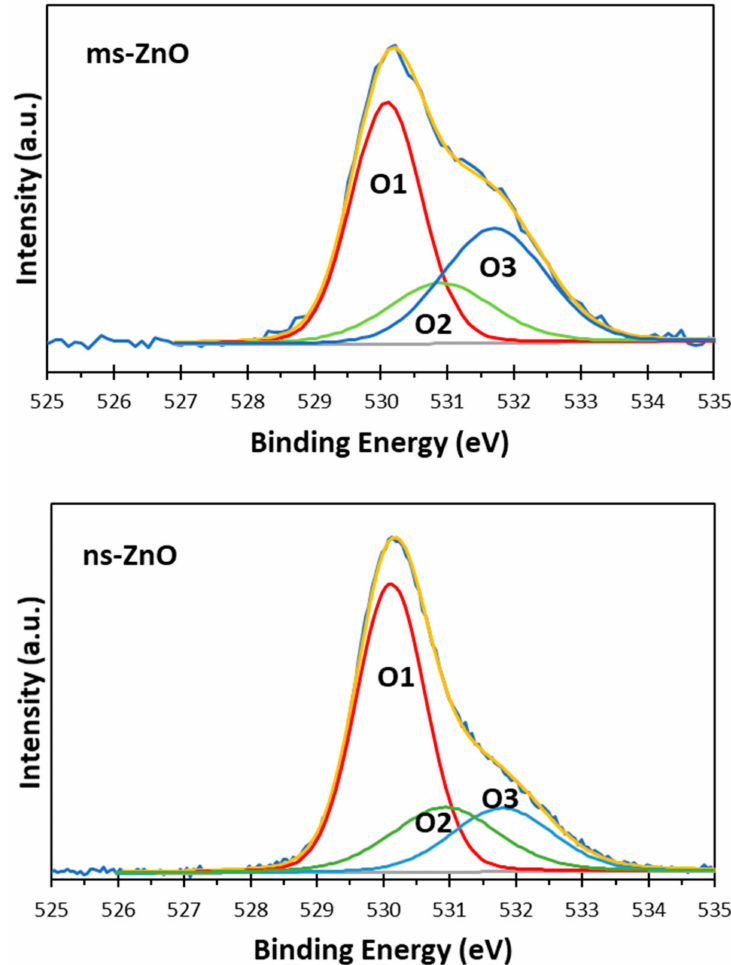
Figure 5. XPS O 1s spectra of ms-ZnO and ns-ZnO samples curve-fitted with three components corresponding to an O 2 − ion in the wurtzite phase surrounded by Zn atoms in their full tetrahedral geometry of nearest oxygen atoms (O1), surface OH groups bonded to Zn 2+ (O2), and chemisorbed oxygen, such as O 2 and adsorbed H 2 O